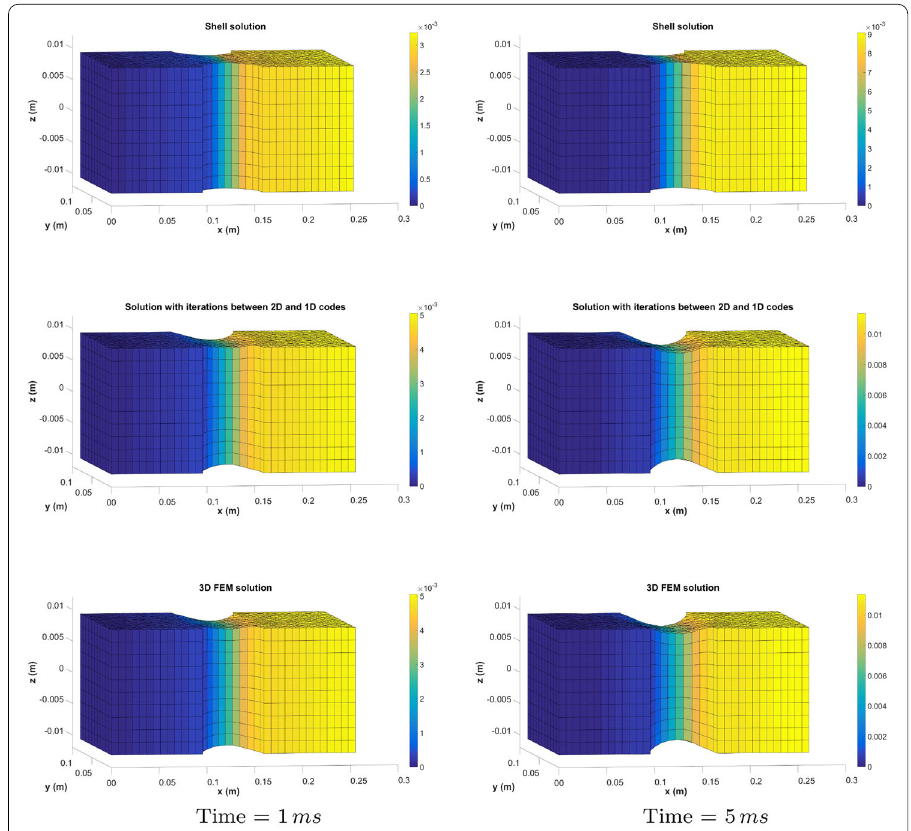
Fig. 15 Displacement field using the three methods for t = 1 ms and t = 5